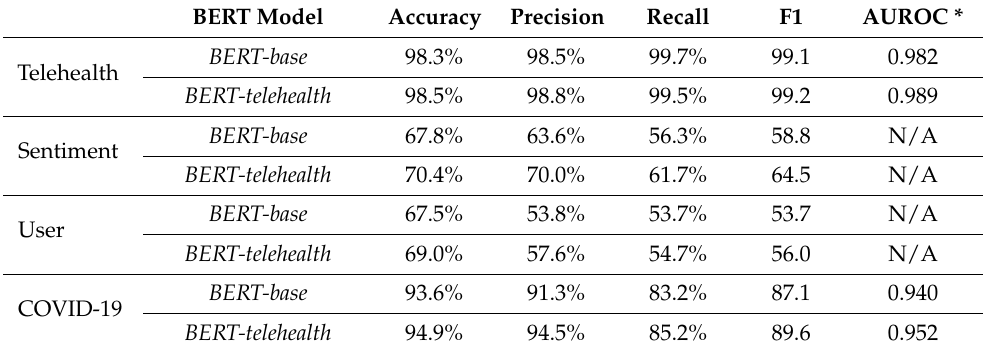
Table 1. Evaluation of the eight fine-tuned BERT models on the test set. Note: sentiment and user are not binary, so precision/recall/F1 are macro metrics and AUROC is not applicable.